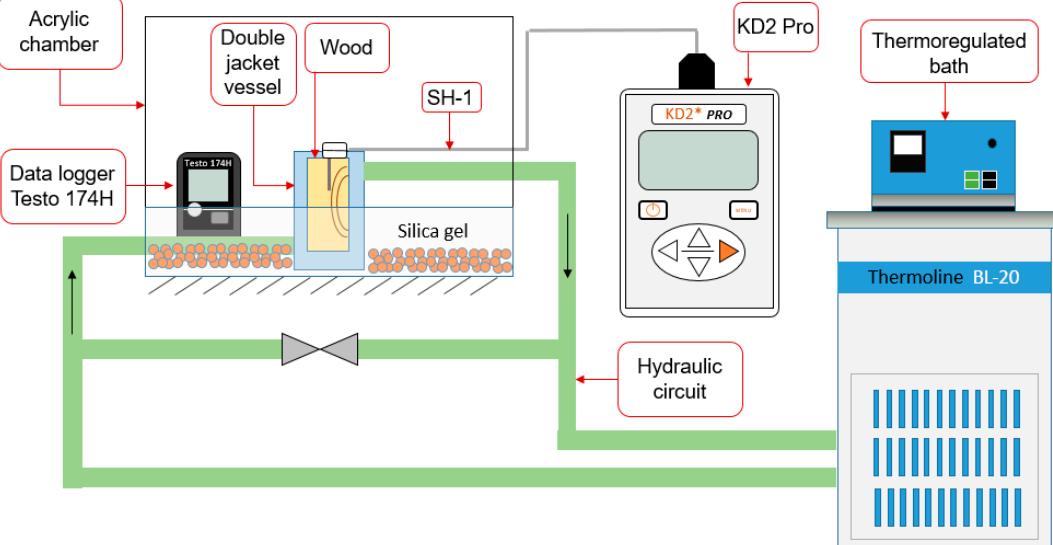
Figure 4. Experimental setup for thermal characterization of phase change material (PCM)-impregnated Pinus radiata wood.